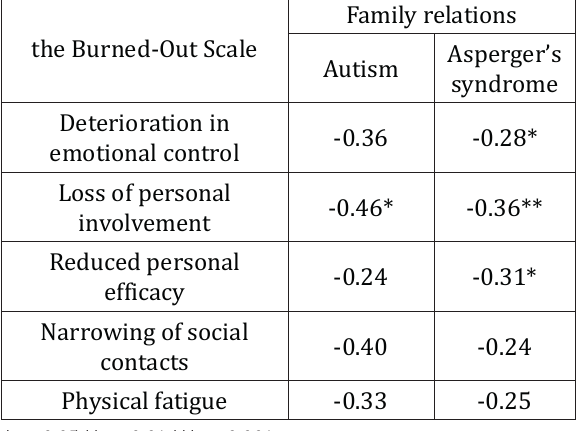
Table 3. Correlation coefficients calculated between the assessment of family relations and the Burned-Out Scale (SWS) scores in the group of mothers of children with autism and Asperger's syndrome